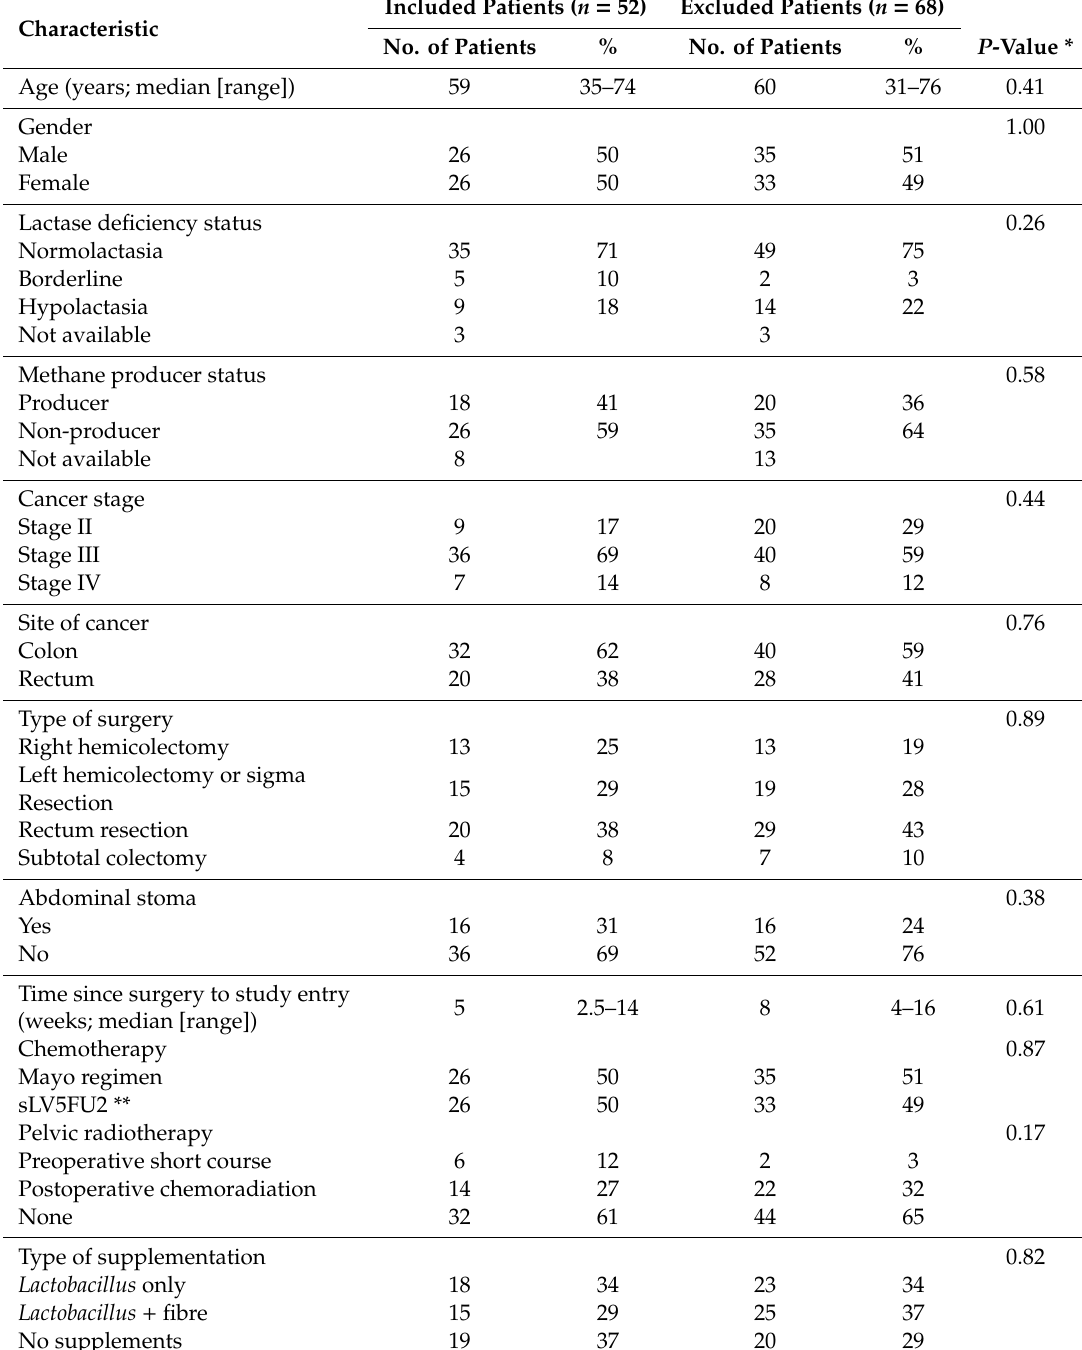
Table 1. Comparison of the baseline characteristics of the LIPSYT trial patients included in the present study with the patients who were